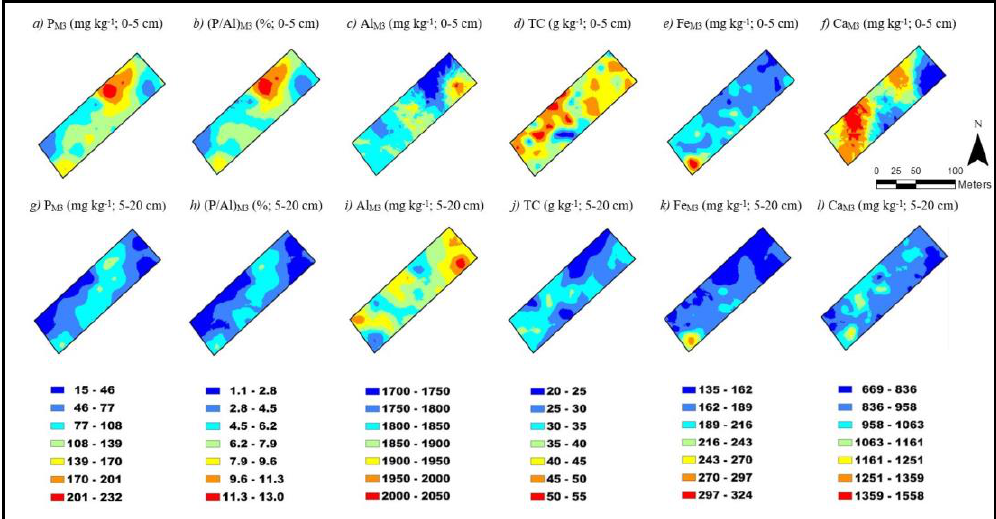
Figure 3. Spatial distribution maps of P M3 ( a , g ), (P/Al) M3 ( b , h ), Al M3 ( c , i ), TC ( d , j ), Fe M3 ( e , k ) and Ca M3 ( f , l ) for the 0 – 5 cm and 5 – 20 cm soil layers, respectively, from the old grassland field in 2013.